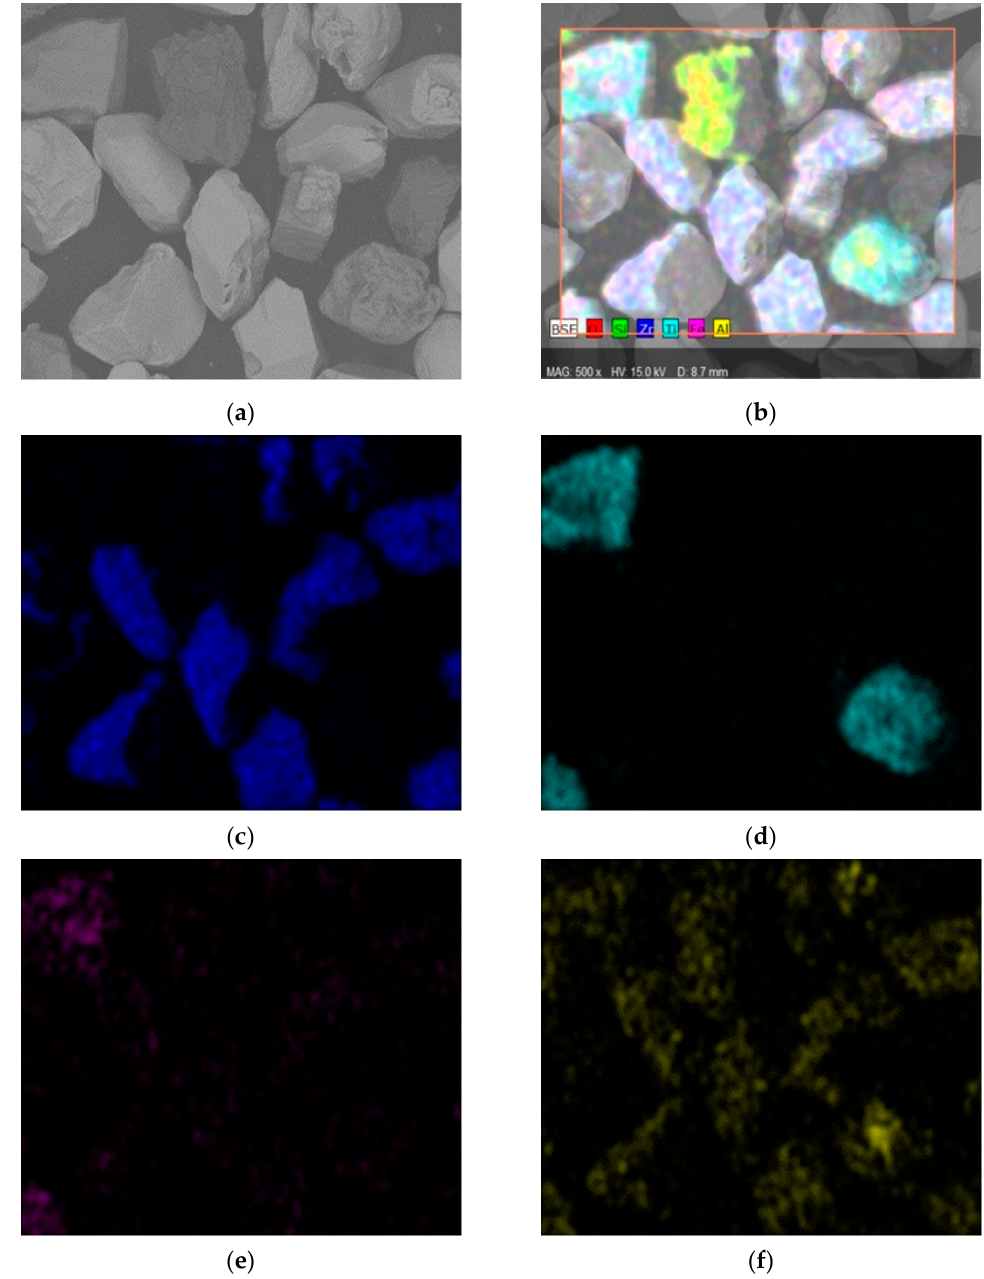
Figure 16. Distribution of the elements: ( a ) zirconium concentrate grains; ( b ) distribution of the elements on the surface; ( c ) zirconium; ( d ) titanium; ( e ) iron; ( f ) aluminum.